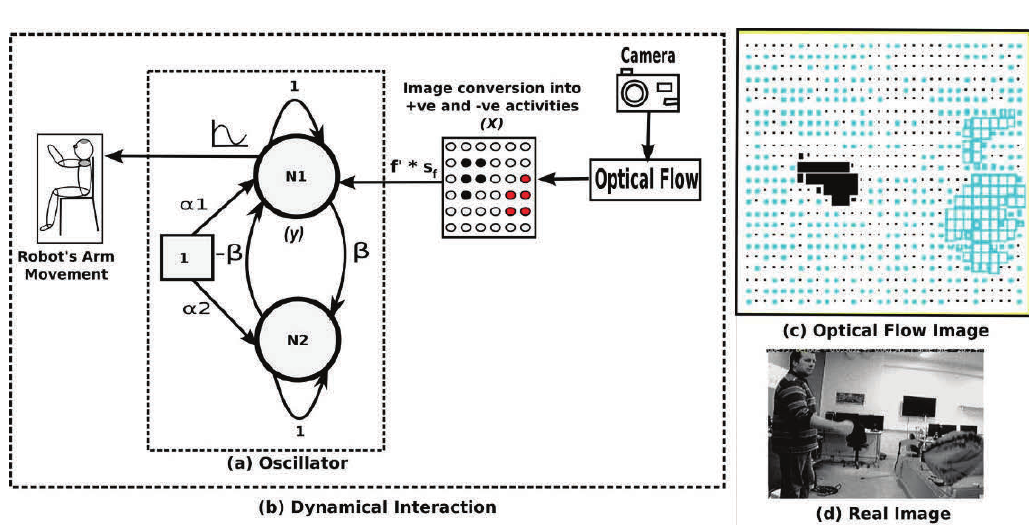
Figure 2. (a) Oscillator model (b) Dynamical Interaction model (c) Positive and negative activities deduced from optical flow: Upward movements (positive) are shown as fulfilled black color pixels, downward movements (negative) are shown by unfilled pixels. (d) A real image captured by the camera